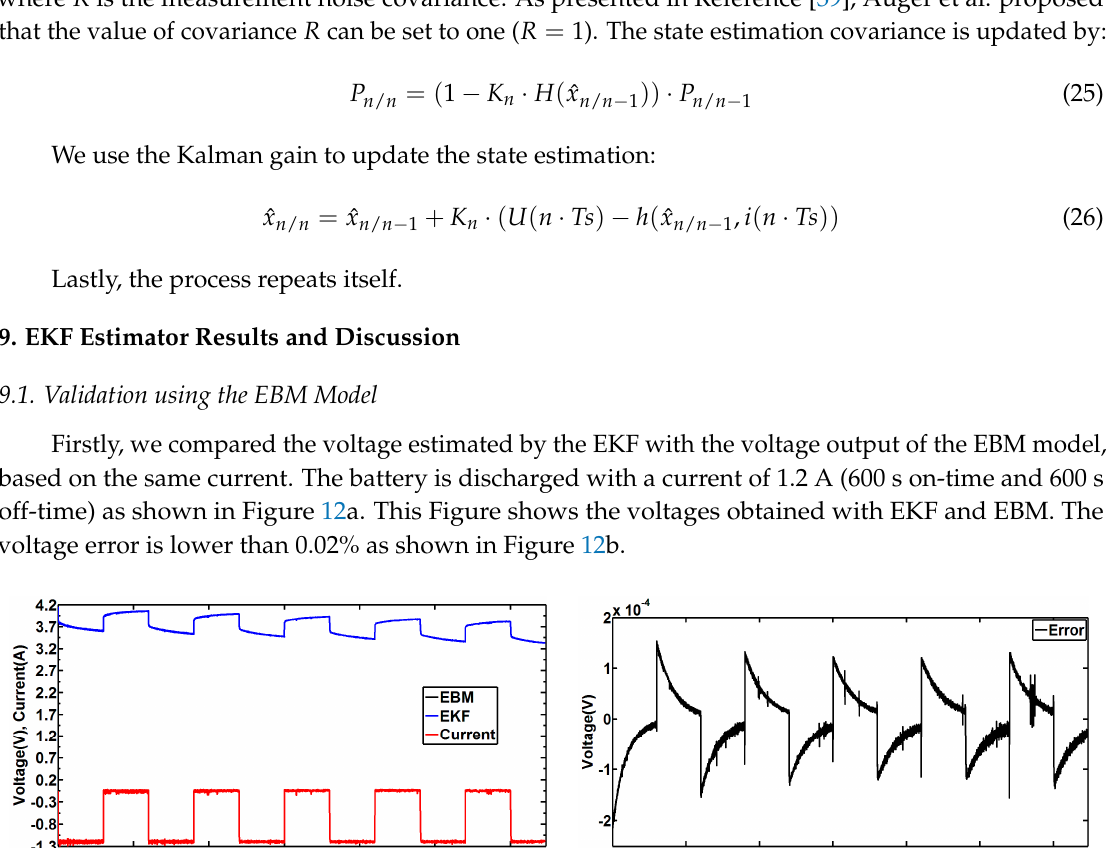
( d ) Figure 13. Comparison of EBM and EKF results for the 1.2 A current profile ( a ) plot of (cid:1873) (cid:2869) , (cid:1873) (cid:2870) and SOC , ( b ) resistances (cid:1844) (cid:2869) ,(cid:1844) (cid:2870) and (cid:1844) (cid:2868) ( c ) time constants (cid:2028) (cid:2869) and (cid:2028) (cid:2870) ( d ) capacitances (cid:1829) (cid:2869) and (cid:1829) (cid:2870) . These estimated parameters vary with time due to their variation with SOC . The main observations concern the resistances which do not vary significantly with time. There is some fluctuation in resistance (cid:1844) (cid:2868) , but it seems to be low. These resistances vary slightly for a SOC interval of 30–100%; conversely, capacitances vary considerably with SOC . These hypothetical observations can be confirmed by experimental results.